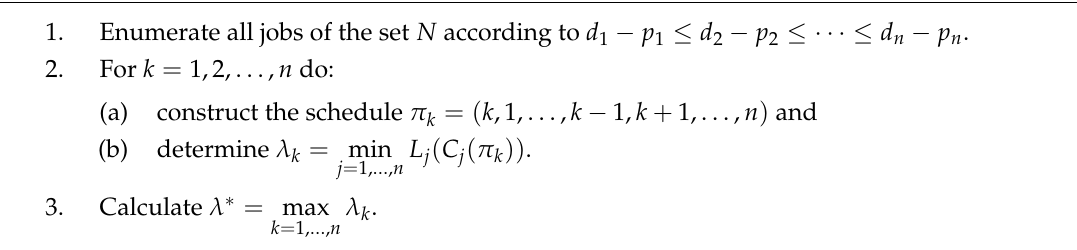
Algorithm 4 constructs n schedules, one of which is satisfying the conditions of the lemma. Algorithm 4: Solution of the inverse problem 1 | r j | max L